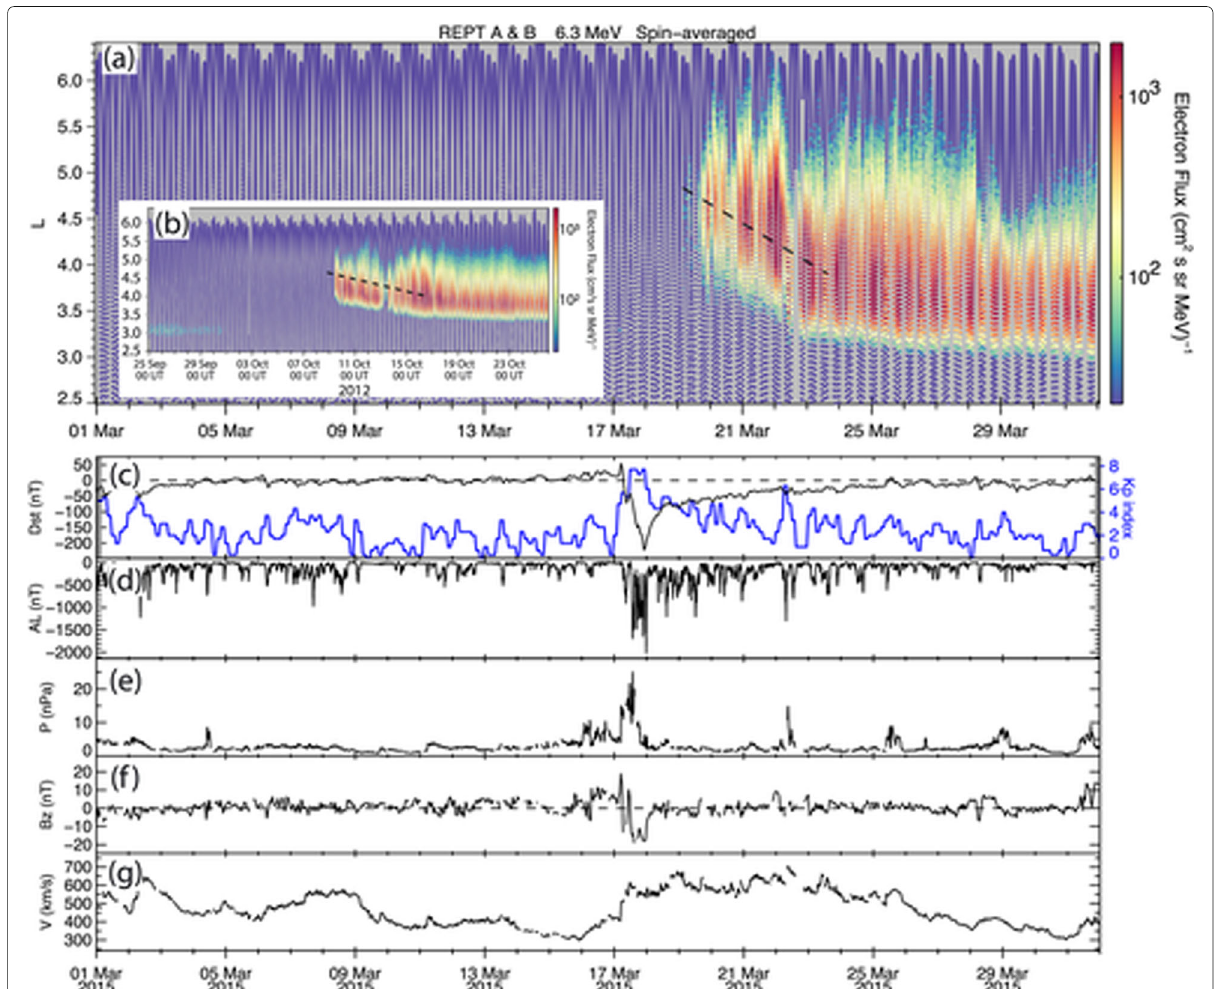
Fig. 9 Radial diffusion of ultra-reltivistic electrons (6.3 MeV) shown in the top panel. Also shown in the top panel is the comparatively slower radial diffusion during October 2012. Compare to much slower diffusion seen in previous strong storm in October 2012, black dashed lines show the slope of inward drift. The rest of the panels show Dst, Kp, AL, and solar wind parameters. Figure is reproduced from Jaynes et al. (2018)